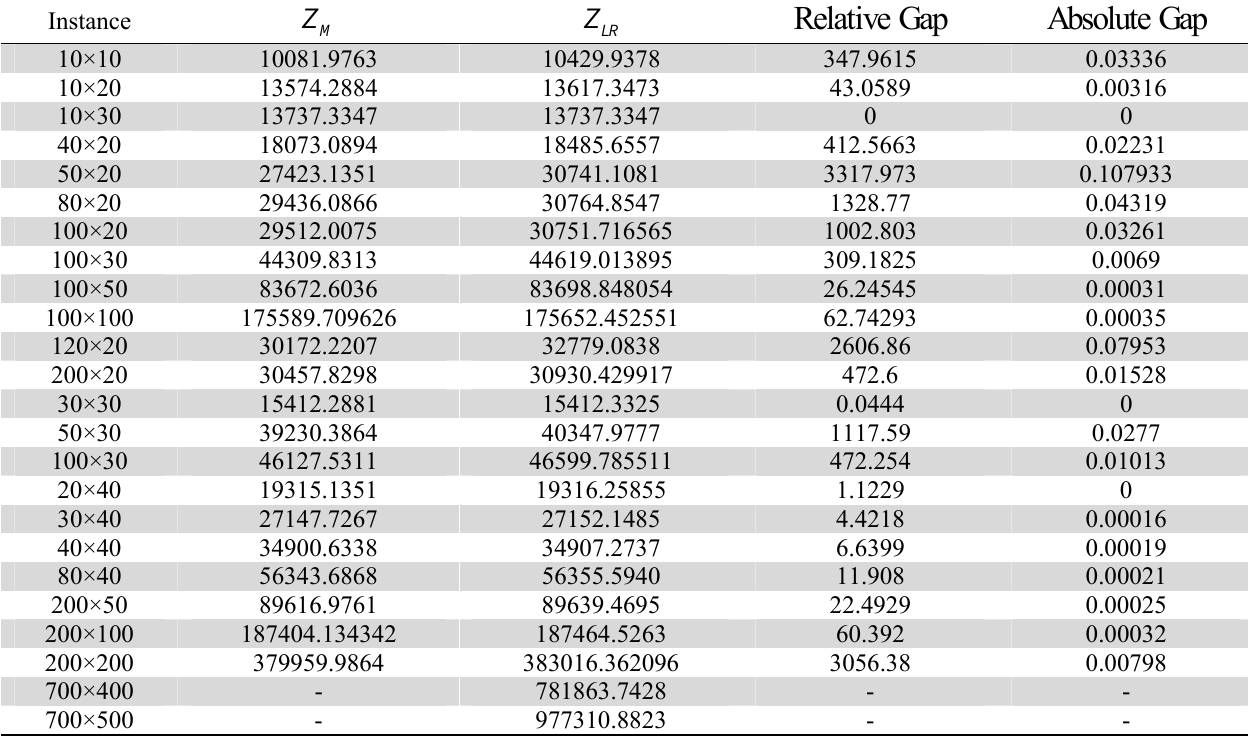
Absolute GapRelative Gap